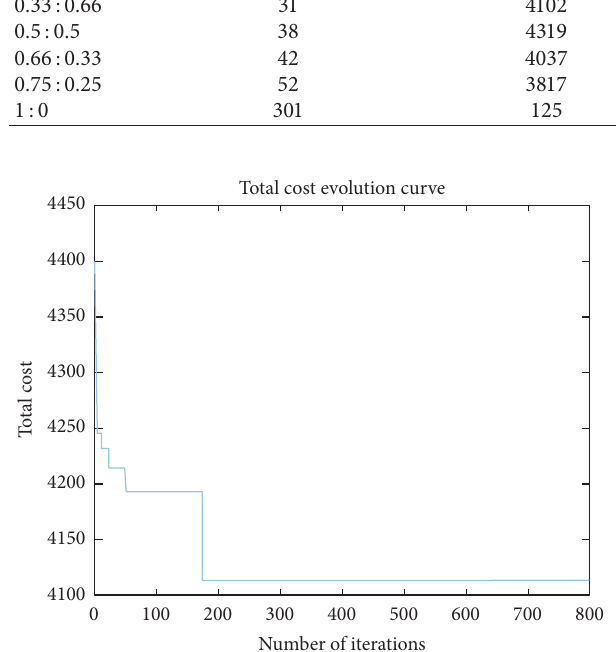
Figure 6: Iterative process of optimal